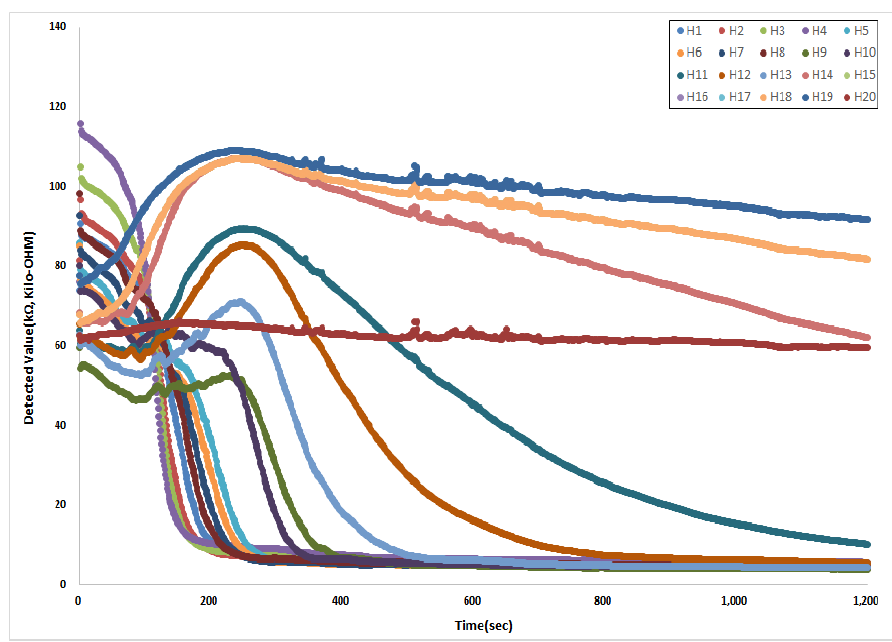
Figure 6. Measurement of the bioreactor sludge by the sludge sedimentation measuring sensor.